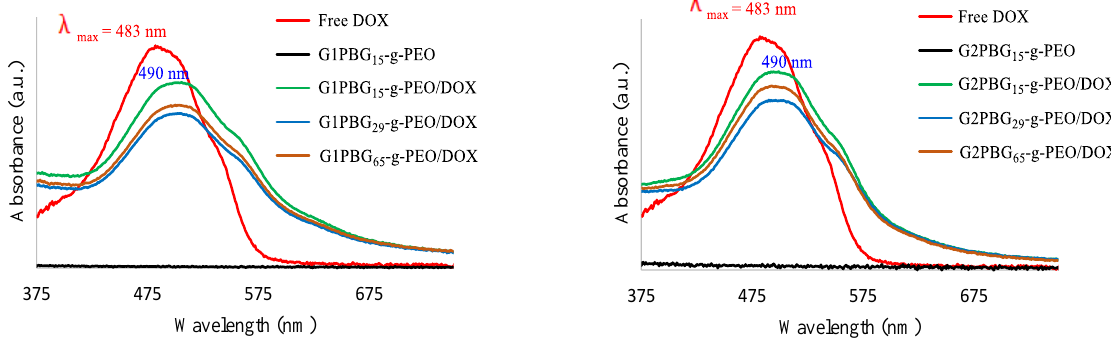
Figure 5. UV Absorption of free DOX, G1 ( left ) and free DOX, G2 ( right ) arborescent copolymers in PBS.